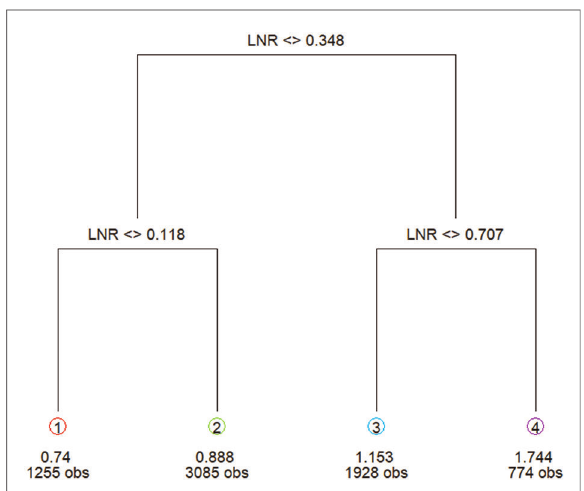
FIGURE 2 The classi fi ed regression tree analysis showed the optimal LNR cutoff